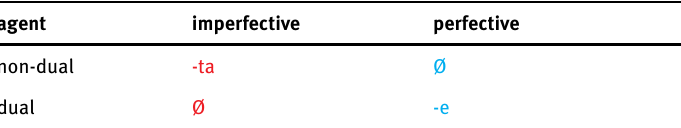
Table 3: Perfectivity